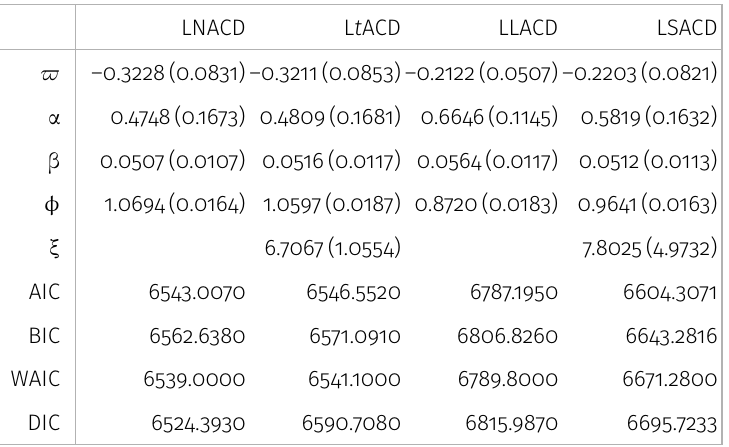
(with estimated standard errors in parentheses). Furthermore, we report the Expected Bayesian Information Criterion (EBIC), Deviance Information Criterion (DIC), Watanabe-Akaike Information Criterion (WAIC) and Bayesian Information Criterion (BIC); see Akaike (1992), Watanabe (2010), Schwarz et al. (1978) and Spiegelhalter et al. (2002). Table IV. Estimates (with SE in parentheses) for fit to the BASF-SE data. LNACD L t ACD LLACD LSACD